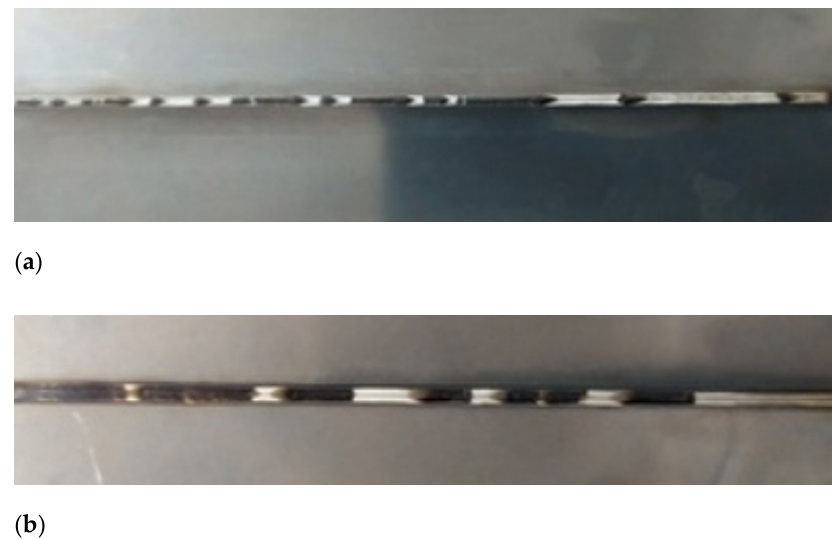
Figure 3. The weld seam top ( a ), and root ( b ) view, × 1.6. Mode parameters: I = 12–14 A; v = 17–18 mm/s; q = 8–14 lpm.